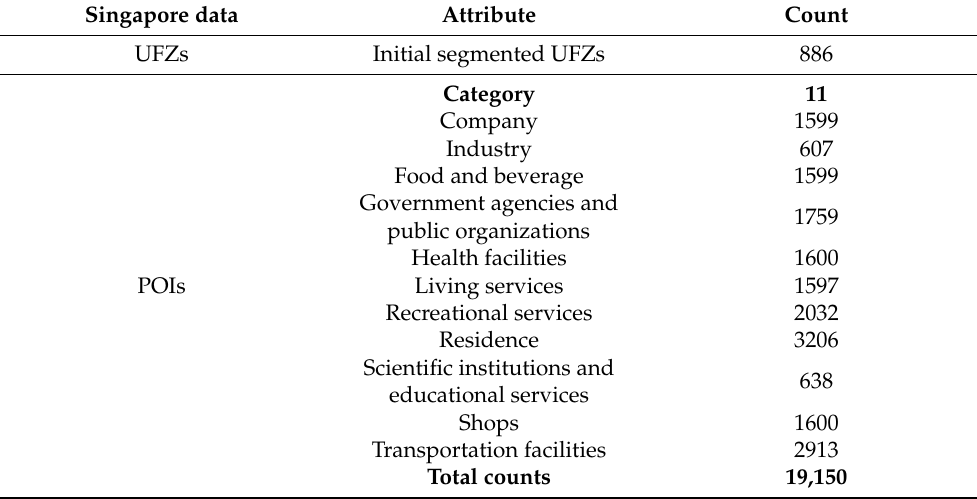
Table 3. Statistics of segmented UFZs and POIs of Singapore